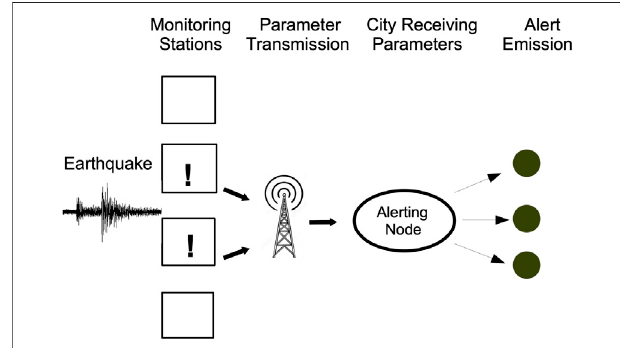
FIGURE 2 | Schematic operation of SASMEX. The dedicated accelerographs continuously monitor ground motion. When two adjoining stations exceed the pre-established thresholds of acceleration during an earthquake, the empirical parameters associated to moment magnitude are sent to central facilities at participating cities via radio links. These nodes then emit the alert to users using the various communication modes.